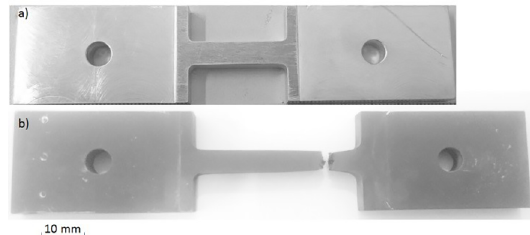
Figure 8. Photography of tensile specimens: a) before and b) after test, the rolling plane is parallel to the page and the rolling direction is horizontal to the page.